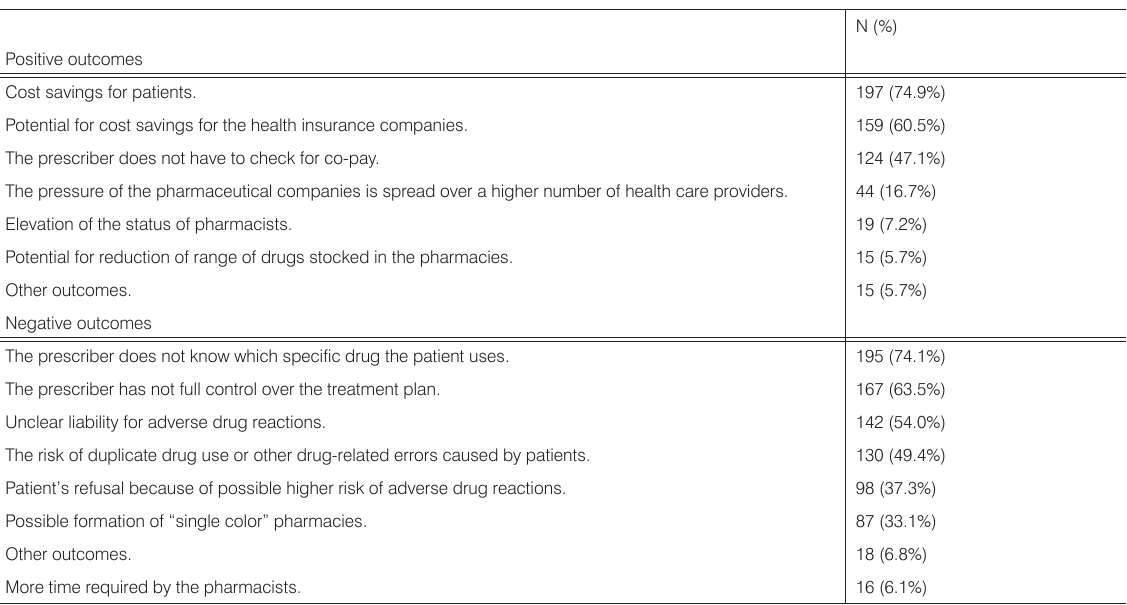
Table 4. Positive and negative outcomes from GP’s